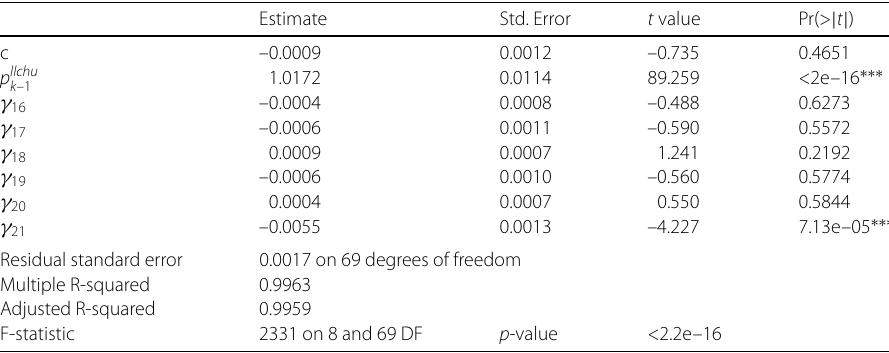
Table 4 Influential significance of events detected for James Soong Estimate Std.